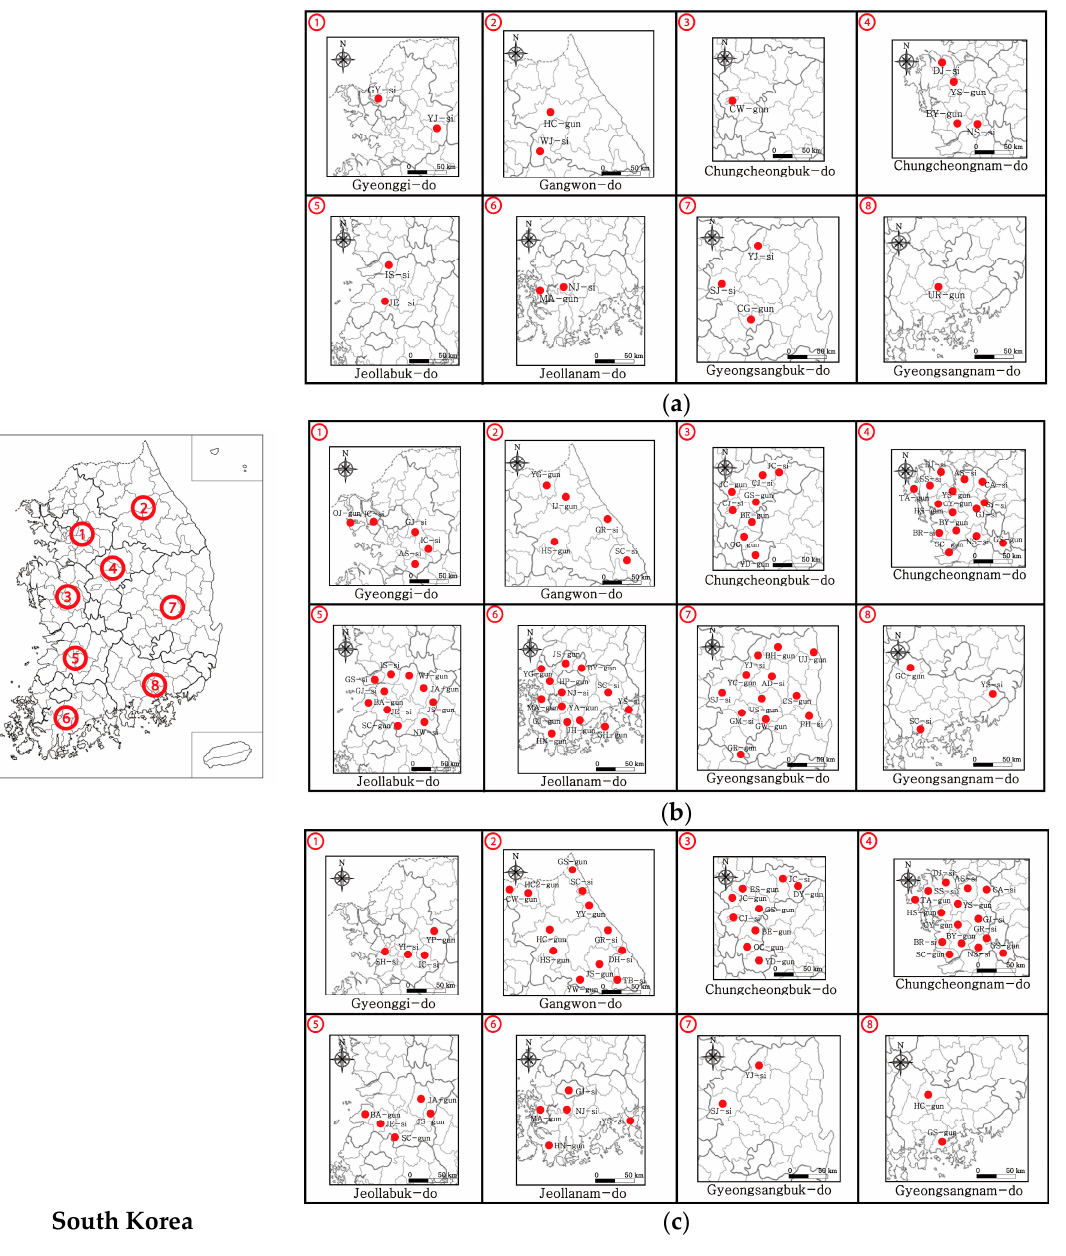
Figure 1. Study areas in ( a ) 2014; ( b ) 2015; ( c ) 2016.